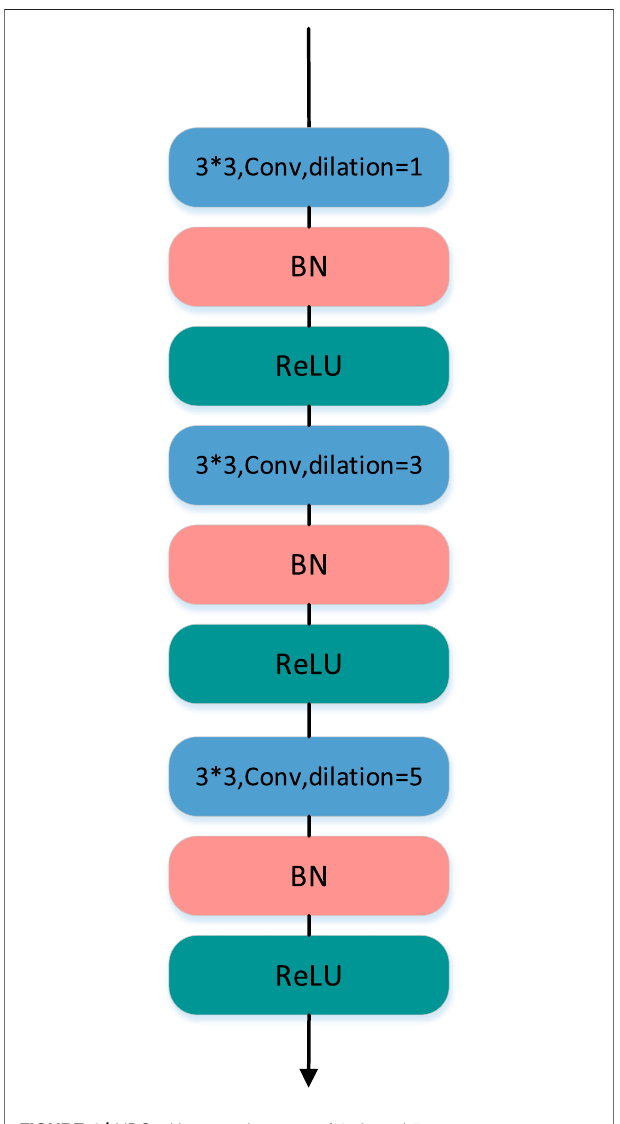
FIGURE 4 | HDC with expansion rates of 1, 3, and